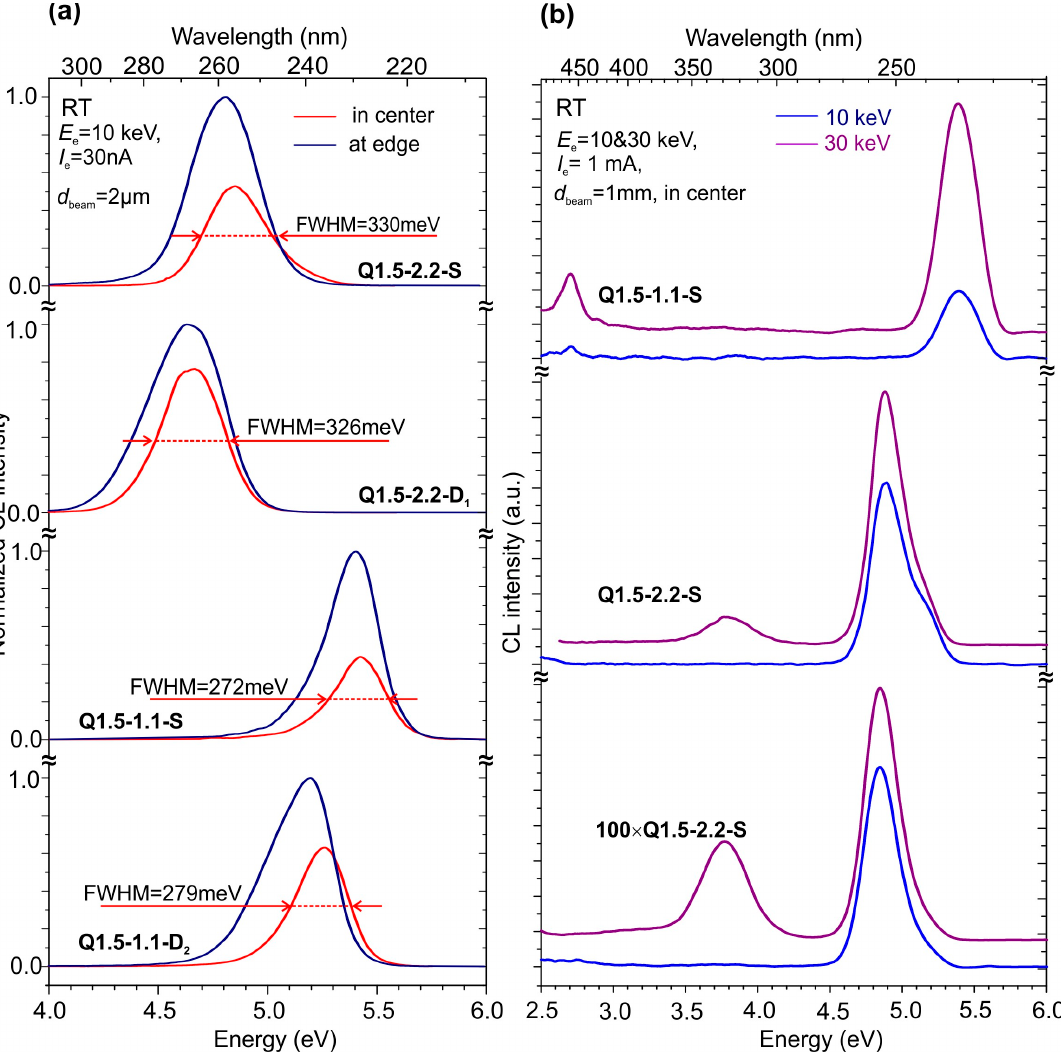
Figure 9. ( a ) Normalized CL spectra at RT excited with a “low-current” thermionic e-gun at the same E e = 10 keV I e = 30 nA, which were measured in the center (red) and at the edge (blue) of a 2-inch substrate in 400 × {GaN 1.5 /AlN 16 } MQW structures grown under various Ga/N 2 * flux ratios on different AlN templates. ( b ) CL spectra excited at RT using a “low-current” thermionic e-gun with E e = 10 (blue) and 30 (violet) keV, I e = 5 µA, which were measured in 400 × {GaN 1.5 /AlN 16 } MQW structures grown under various Ga/N 2 * flux ratios on different AlN templates.